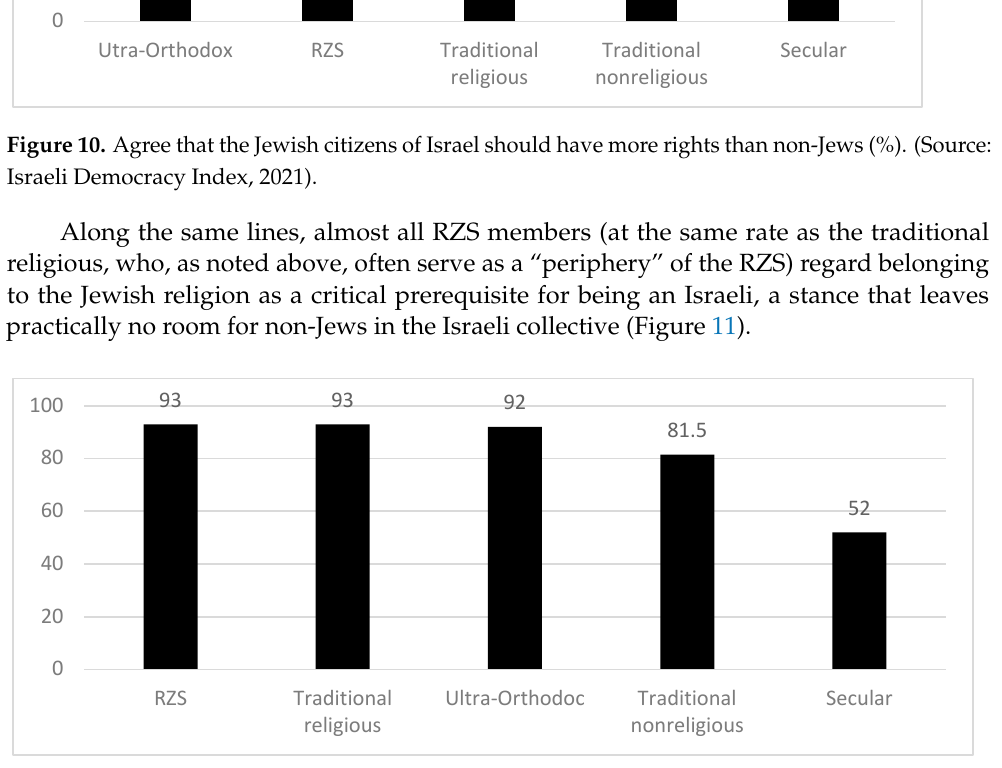
Figure 11. Agree that one should be Jewish in order to be an Israeli, by level of religiosity (%).